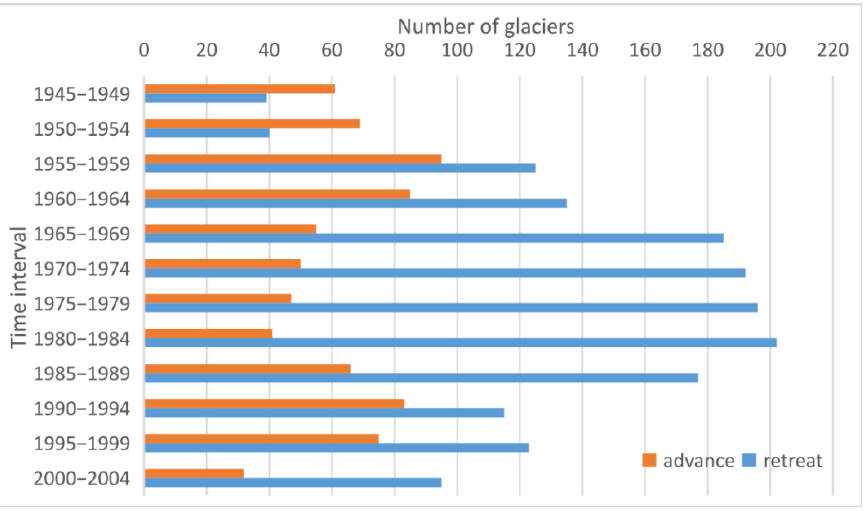
Figure 11. Numbers of glaciers undergoing advancement and recession in particular time intervals [61]. vals [61].